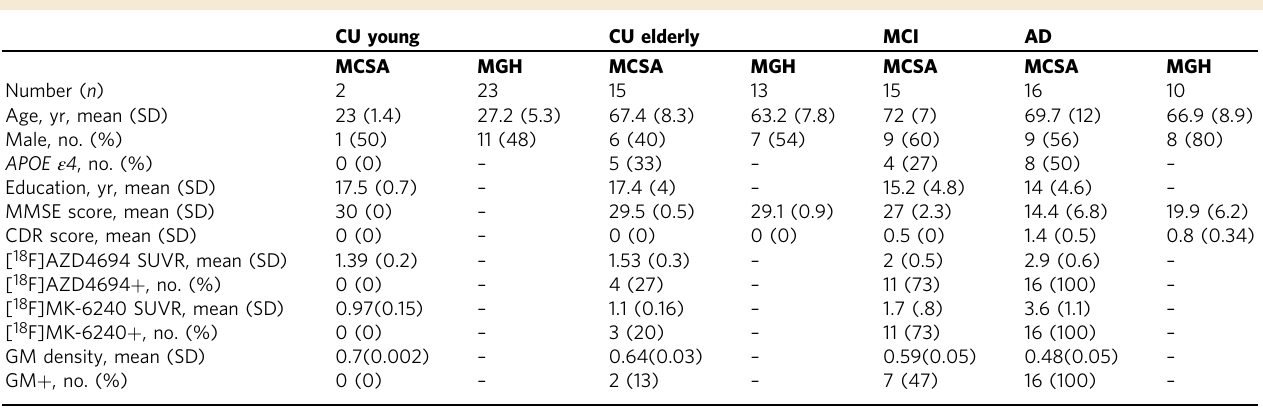
Table 1 Demographics of the participants in each study